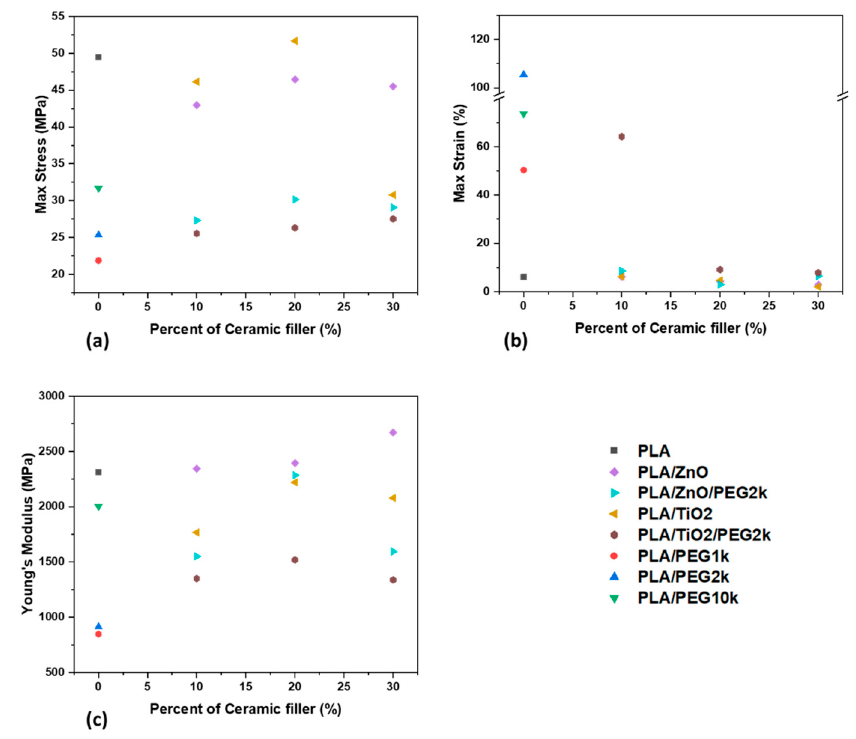
Figure 8. The mechanical properties of the composite filaments: ( a ) max stress; ( b ) max strain; and ( c ) Young’s modulus.